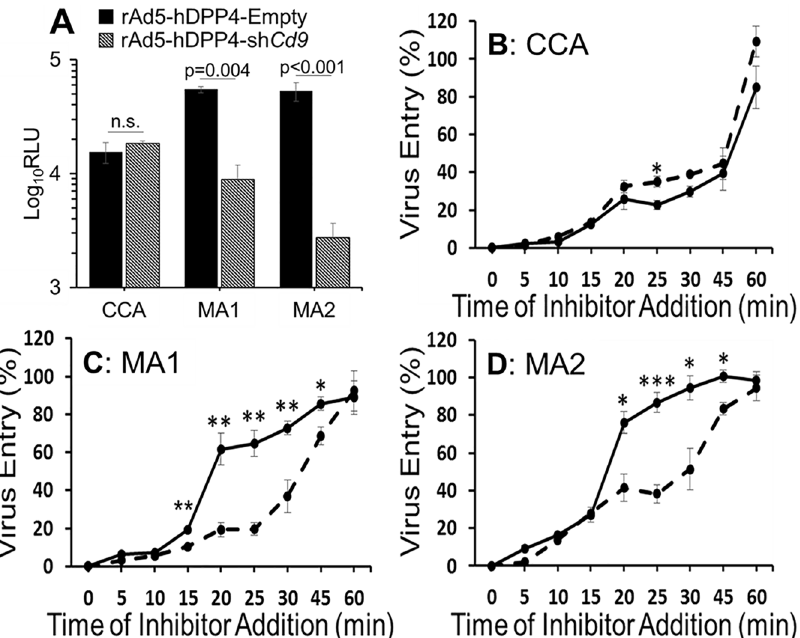
Fig 6. CD9utilization of high virulenceMERSviruses. (A)LET-1 cellsweretransduced withrAd5-hDPP4- Empty (blackbars)or rAd5-hDPP4-sh Cd9 (dashedbars)beforetransduction with VSV-ppscarryingthe indicated MERS S proteins.The entry kineticsof MERSppscarrying cell-cultureadapted(B), MA1(C), or MA2 (D) S proteinswas measured in LET-1 cells previously transduced with rAd5-hDPP4-Empty(solidlines)or rAd5-hDPP4-shCd9(dashedlines).Virusentry wascalculated relativeto a non-inhibitor treatedcondition. * p < 0.05, ** p < 0.01, *** p < 0.001